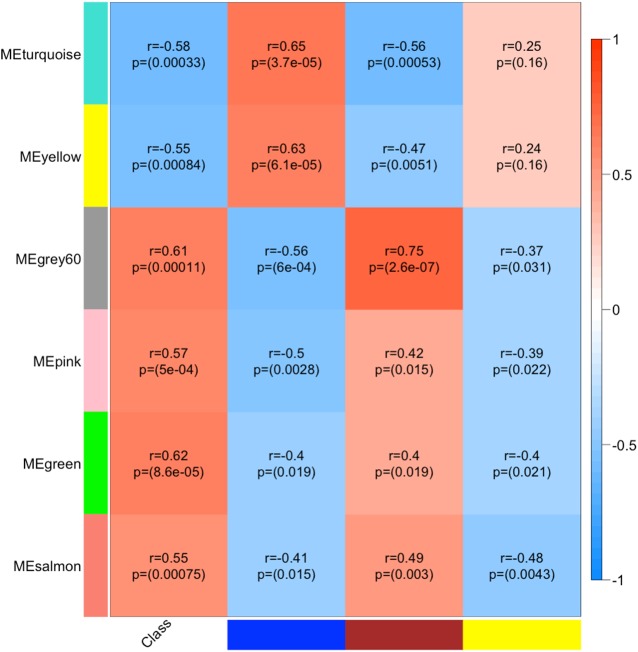
miRNA:mRNA Module relationships: Significant mRNA module MEs (rows) are correlated (Pearson) to significant miRNA MEs for blue, brown and yellow modules (columns).Strongest correlations is positive between miRNA MEbrown and mRNA MEgrey60 (r = 0.75) and strongest negative correlation is between miRNA MEbrown and mRNA MEturquoise (r = -0.56) and miRNA MEblue and mRNA MEgrey60 (r = -0.56). miRNA MEblue and MEyellow are negatively correlated with glial cell-associated mRNA modules and miRNA MEbrown is negatively with neuron-associated mRNA modules.